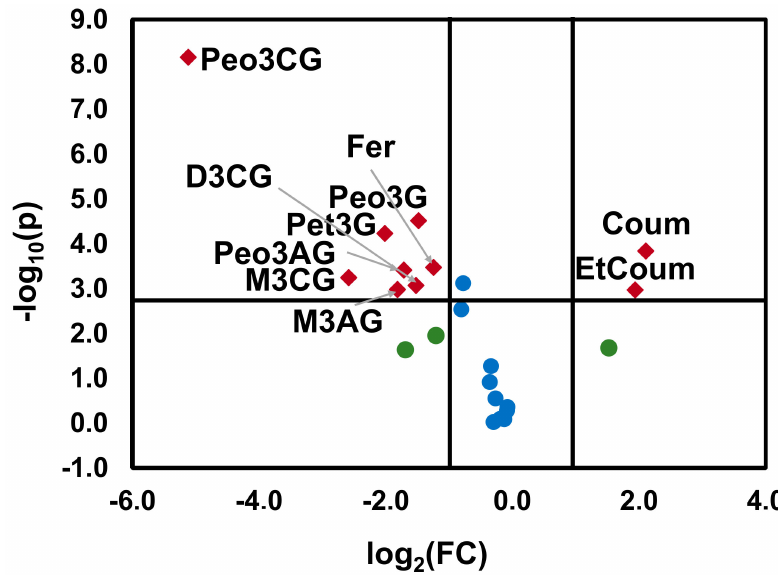
Figure 3. Volcano plot representing the statistical significance ( p -values) on the Mann–Whitney non-parametric test and the fold change (FC) for the anthocyanins, phenolic acids, and catechin of wines ‘Menc í a’ / ‘Jaen’ wines from Bierzo D.O. and D ã o D.O., respectively. The horizontal line represents the threshold of significance corrected for multiple comparisons by Bonferroni’s method ( p = 0.00217). Delphinidin-3-glucoside (D3G), cyanidin-3-glucoside (C3G), peonidin-3-glucoside (Peo3G), petunidin-3-glucoside (Pet3G), malvidin-3-glucoside (M3G), delphinidin-3-acetylglucoside (D3AG), cyanidin-3-acetylglucoside (C3AG), peonidin-3-acetylglucoside (Peo3AG), petunidin-3-acetylglucoside (Pet3AG), malvidin-3-acetylglucoside (M3AG), delphinidin-3-coumaroylglucoside (D3CG), peonidin-3- coumaroylglucoside (Peo3CG), malvidin-3-coumaroylglucoside (M3CG), gallic acid (Gal), caftaric acid (Caft), coutaric acid (Cout), coutaric acid isomer (Cout2), ca ff eic acid (Caf), coumaric acid (Coum), catechin (Cat), ethyl ester of ca ff eic acid (EtCaf), ethyl ester of coumaric acid (EtCoum). 2.2. E ff ect of Bierzo D.O. and D ã o D.O. Terroirs on the Anthocyanins and Phenolic Acid Composition